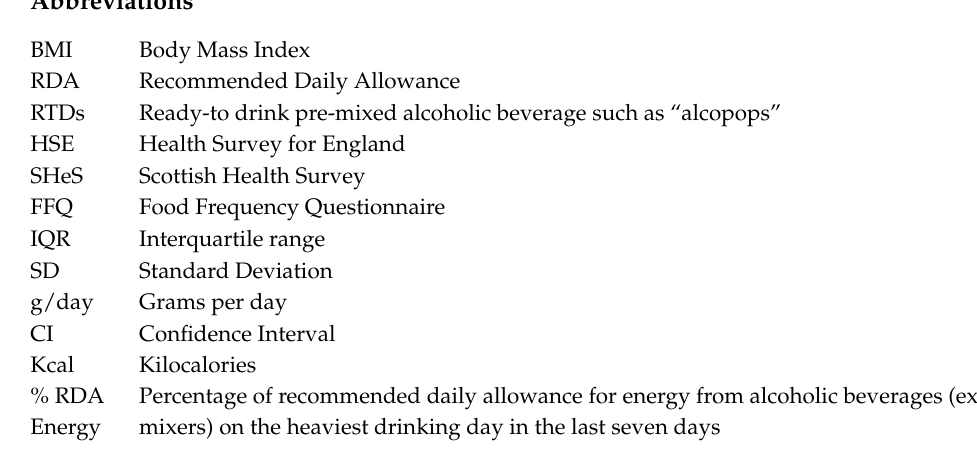
Figure S1: Relationship of BMI to category of intake of energy from beer intake (% RDA Energy) on heaviest drinking day to energy intake by sex, Figure S2: Relationship of BMI to category of intake of energy from wine (%RDA Energy) on heaviest drinking day by sex, Figure S3: Relationship of BMI to category of intake of energy from spirits and RTD (%RDA Energy) on heaviest drinking day by sex, Table S1: Survey year and sample sizes per year used in analyses, Table S2: Regression results for BMI and category of intake of energy from total alcoholic beverages (%RDA Energy) on the heaviest drinking day by sex, Table S3: Regression results for BMI and category of intake of energy from beer intake (%RDA Energy) on heaviest drinking day by sex, Table S4: Regression results for BMI and category of intake of energy from wine intake (% RDA Energy) on heaviest drinking day by sex, Table S5: Regression results for BMI and category of intake of energy from spirits and RTDs intake (% RDA Energy) on heaviest drinking day by